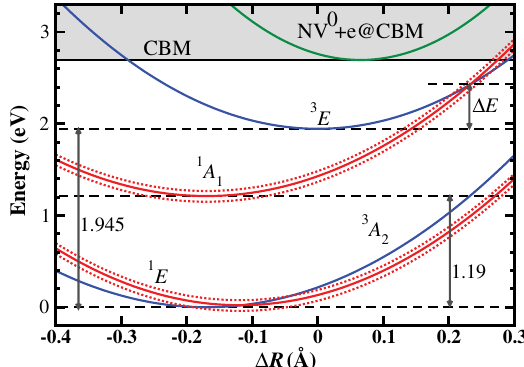
FIG. 3. Configuration coordinate diagram of the NV (cid:5) center. (cid:1) R measures the total displacement of all atoms along the path that interpolates between equilibrium geometries in the 3 A 2 and 3 E electronic states. All energies are relative to the 3 A 2 state’s equilibrium energy. We placed the 1 A 1 state based on the assumption that its equilibrium atomic configuration and vibra- tional frequencies were similar to those of the 3 A 2 state and using our measurement of (cid:1) E . The 1 E state was placed 1.19 eV below the 1 A 1 state based on their known energy difference. The uncertainties in the 1 A 1 and 1 E energies reflect the uncertainty in (cid:1) E (68% interval, dotted red lines). The triplet (1.945 eV) and singlet (1.19 eV) zero-phonon lines are also